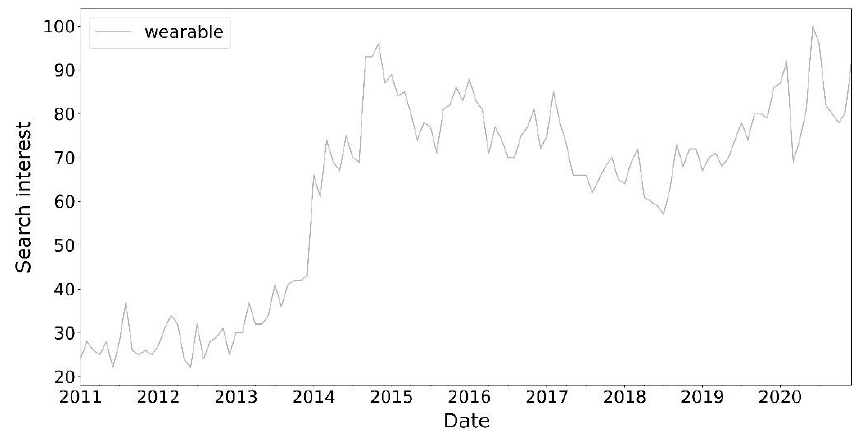
Figure 1. The global trend over the last 10 years of the keyword “ wearable ”— Google, 2020.